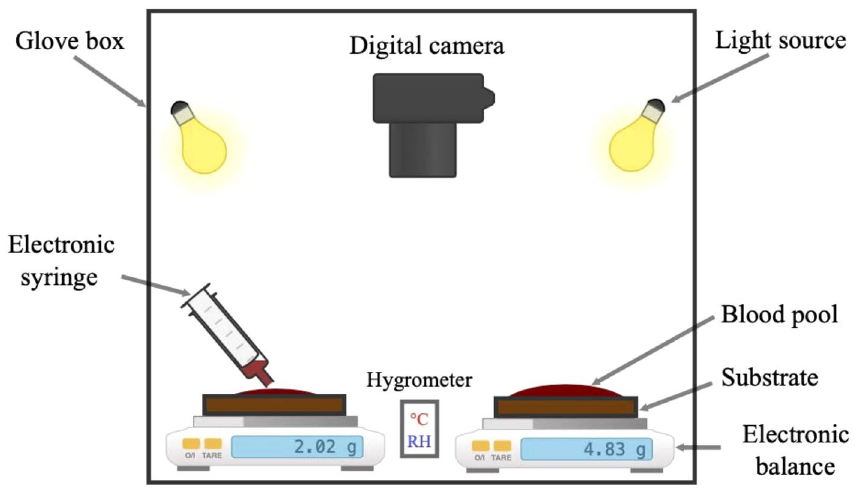
Figure 1. Experimental setup inside the glove box, with a relative humidity control